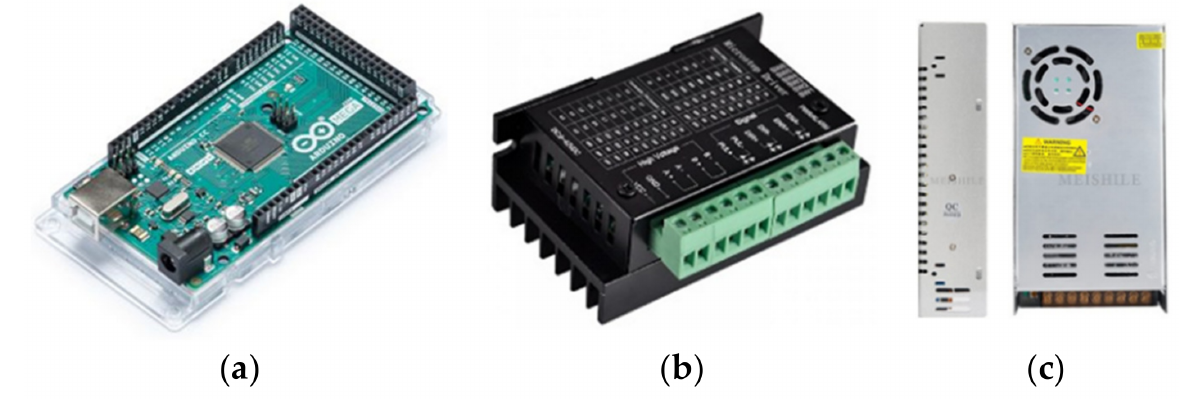
Figure 9. ( a ) Controller board; ( b ) step motor driver; ( c ) power